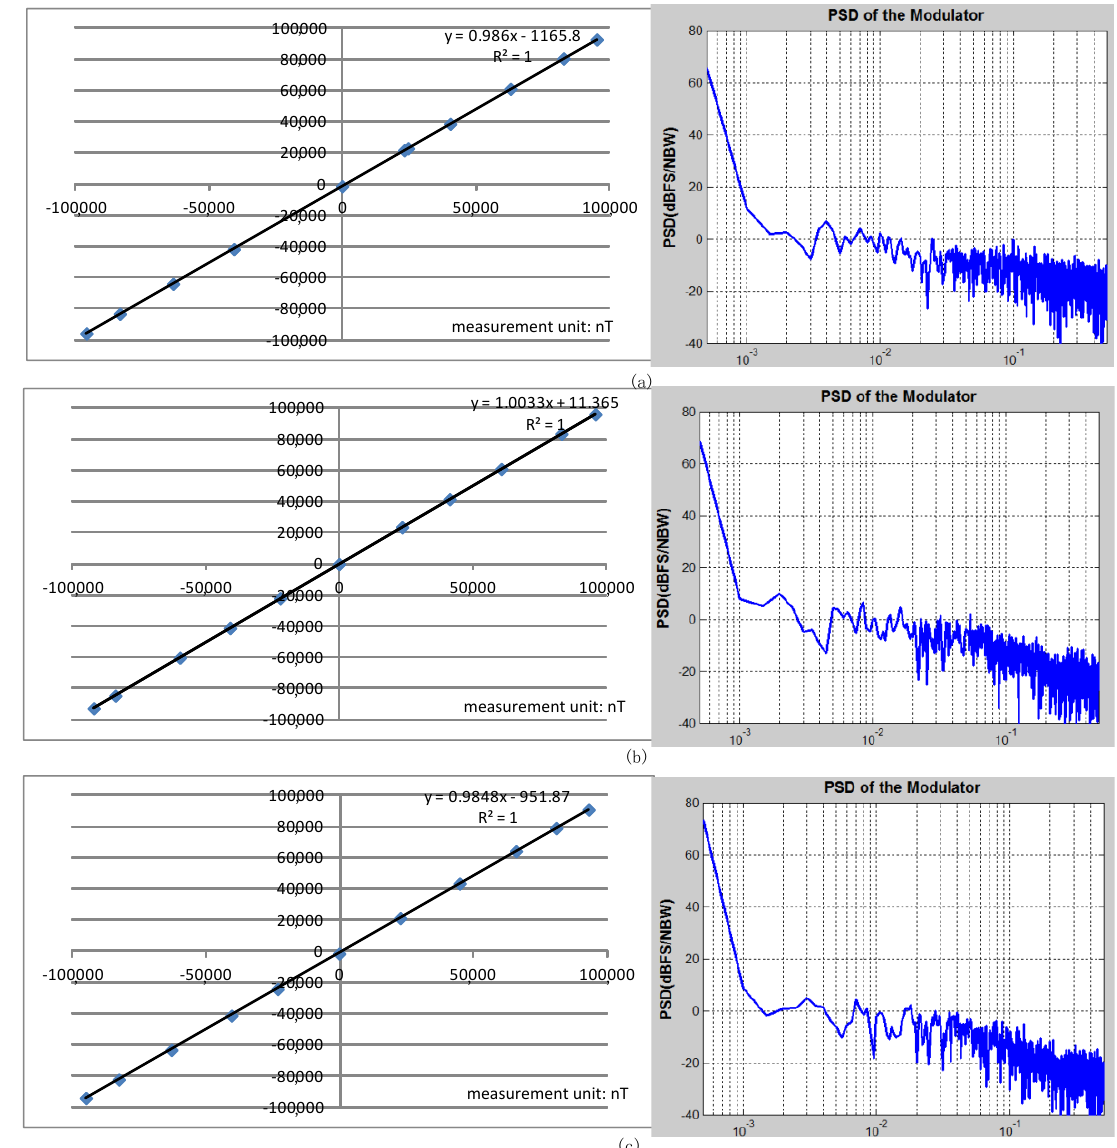
Figure 11. ( a ) The linearity and noise test of TMR magnetometer x -axis ( b ) The linearity and noise test of TMR magnetometer y -axis ( c ) The linearity and noise test of TMR magnetometer z